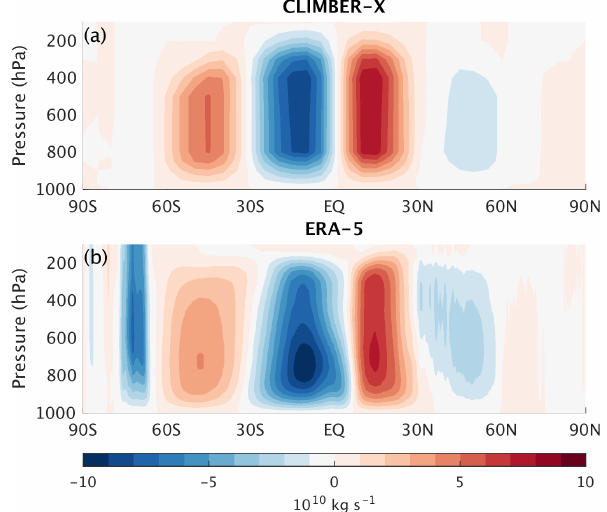
Figure 3. Annual mean (a) simulated meridional atmospheric streamfunction compared to (b) ERA-5 reanalysis (Hersbach et al.,